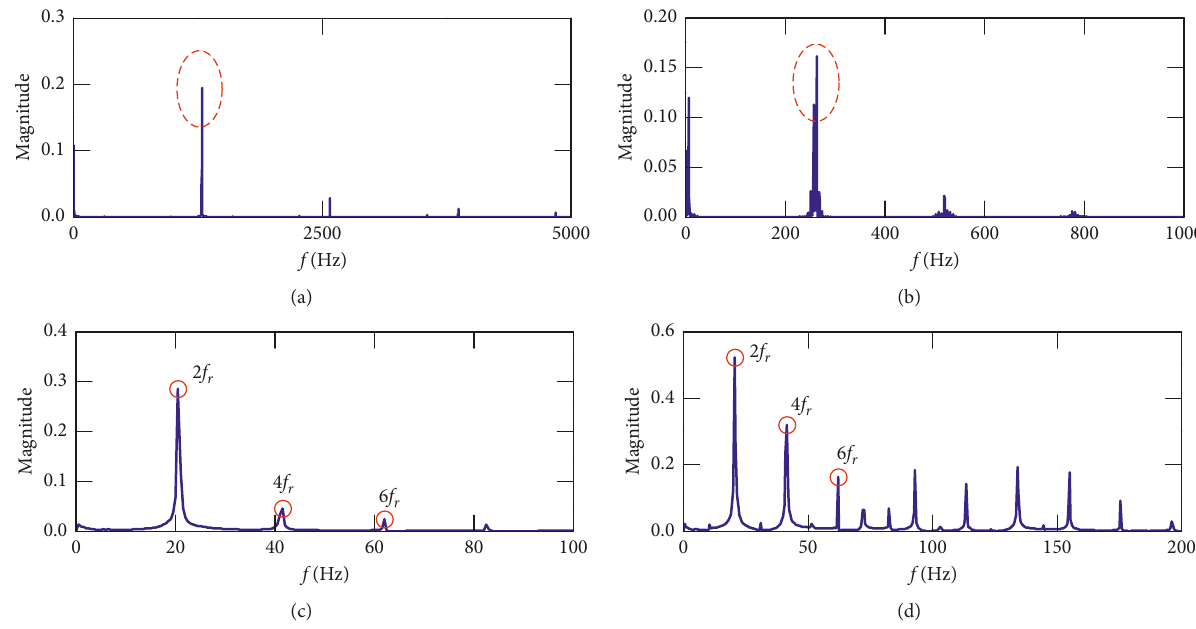
Figure 17: Results obtained by Hankel-SVD for a bearing roller fault signal: (a–d) envelope spectra of IMF 1, IMF 2, IMF 3, and IMF 4, respectively.